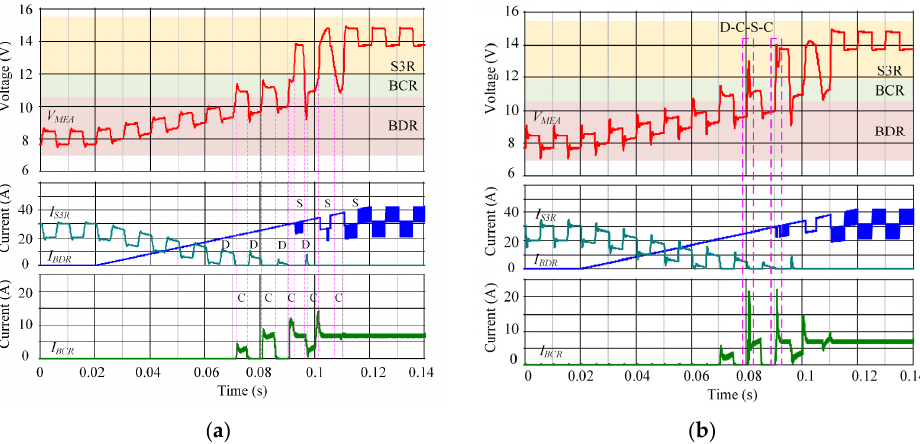
Figure 28. Waveforms of PCU with 20–30 kW pulsed load during the earth eclipse period. ( a ) Normal pulse load. ( b ) Pulse loads with switching fast speed of 40 A/ μ s.